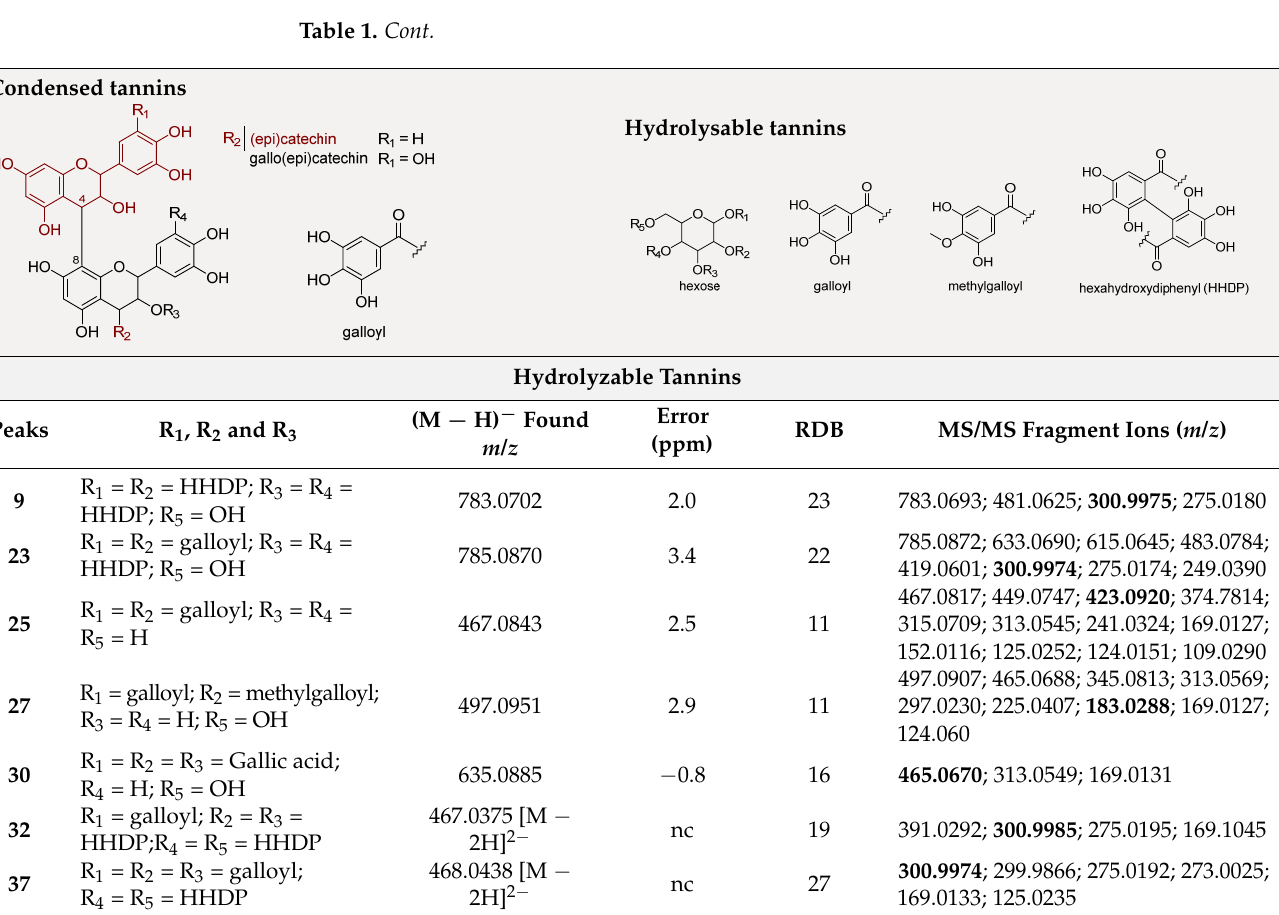
Table 1. TOF-MS data of hydrolysable and condensed tannins tentatively identified in oak leaf. RDB = ring double bond equivalent value. Base peak fragments are reported in bold.